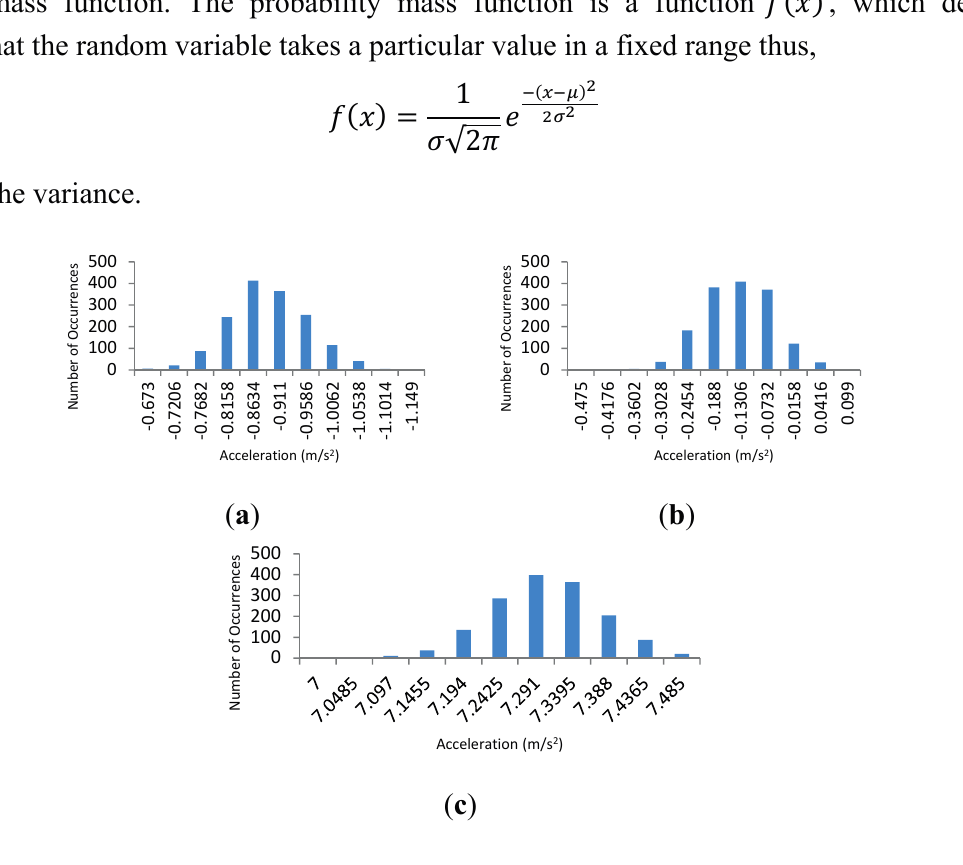
Figure 2. Calibrated accelerometer normalization graph for the ( a ) x -axis; ( b ) y -axis; and ( c ) z